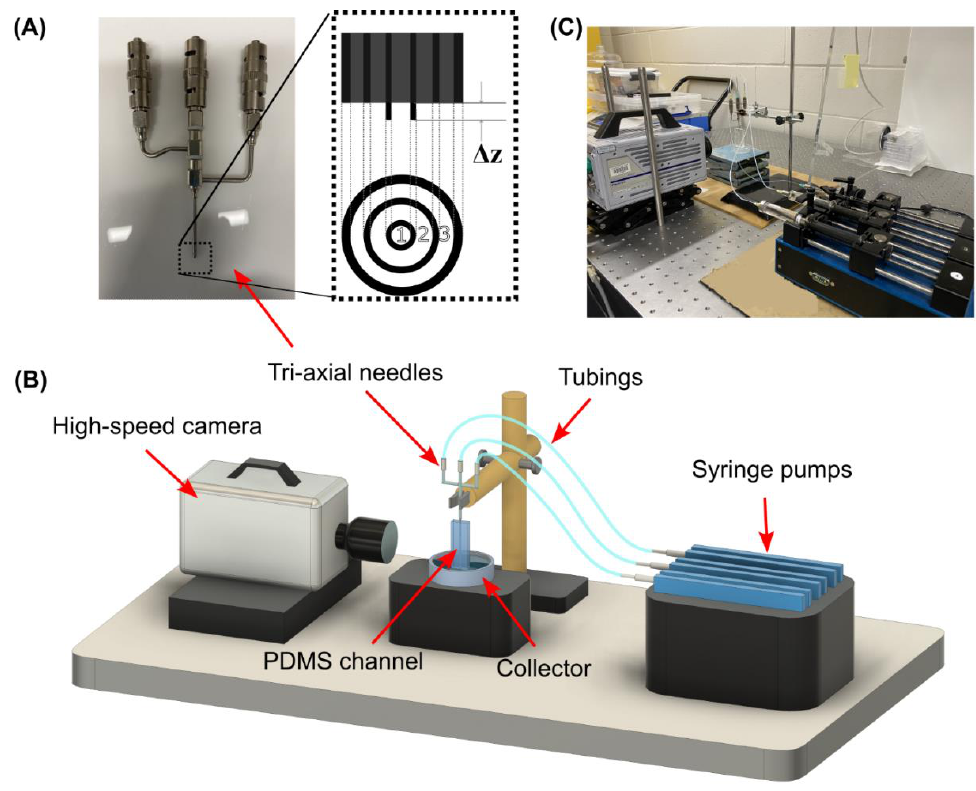
Figure 1. The capillary device used in this study: ( A ) the tri-axial needles; ( B ) the schematic diagram; ( C ) the photo of the experiment setup. Table 1. The dimensions of the tri-axial needles.